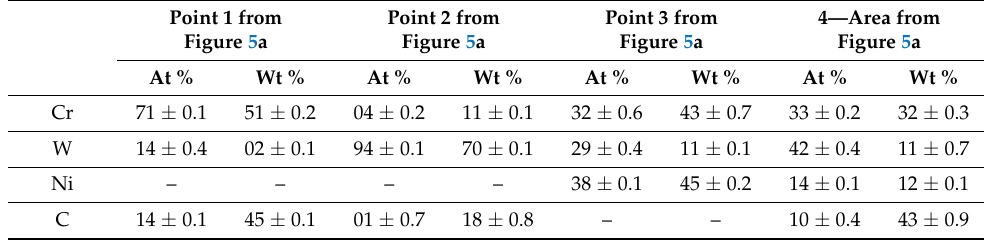
Table 3. Results of the chemical composition analysis of the WC coating.